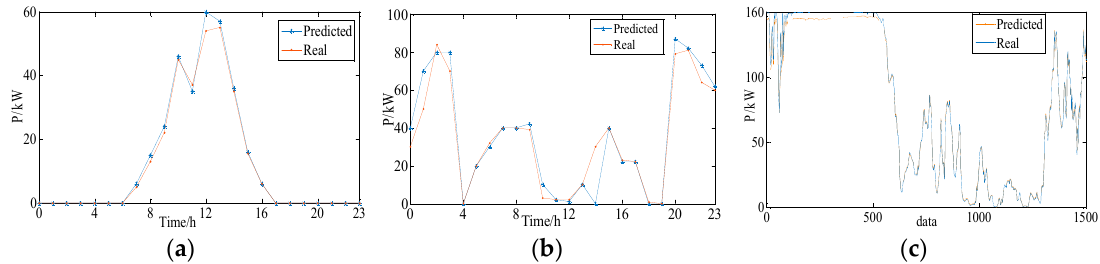
Figure 4. PV output per hour ( a ), WT output per hour ( b ), WT Prediction and actual output of 1500 data ( c ).